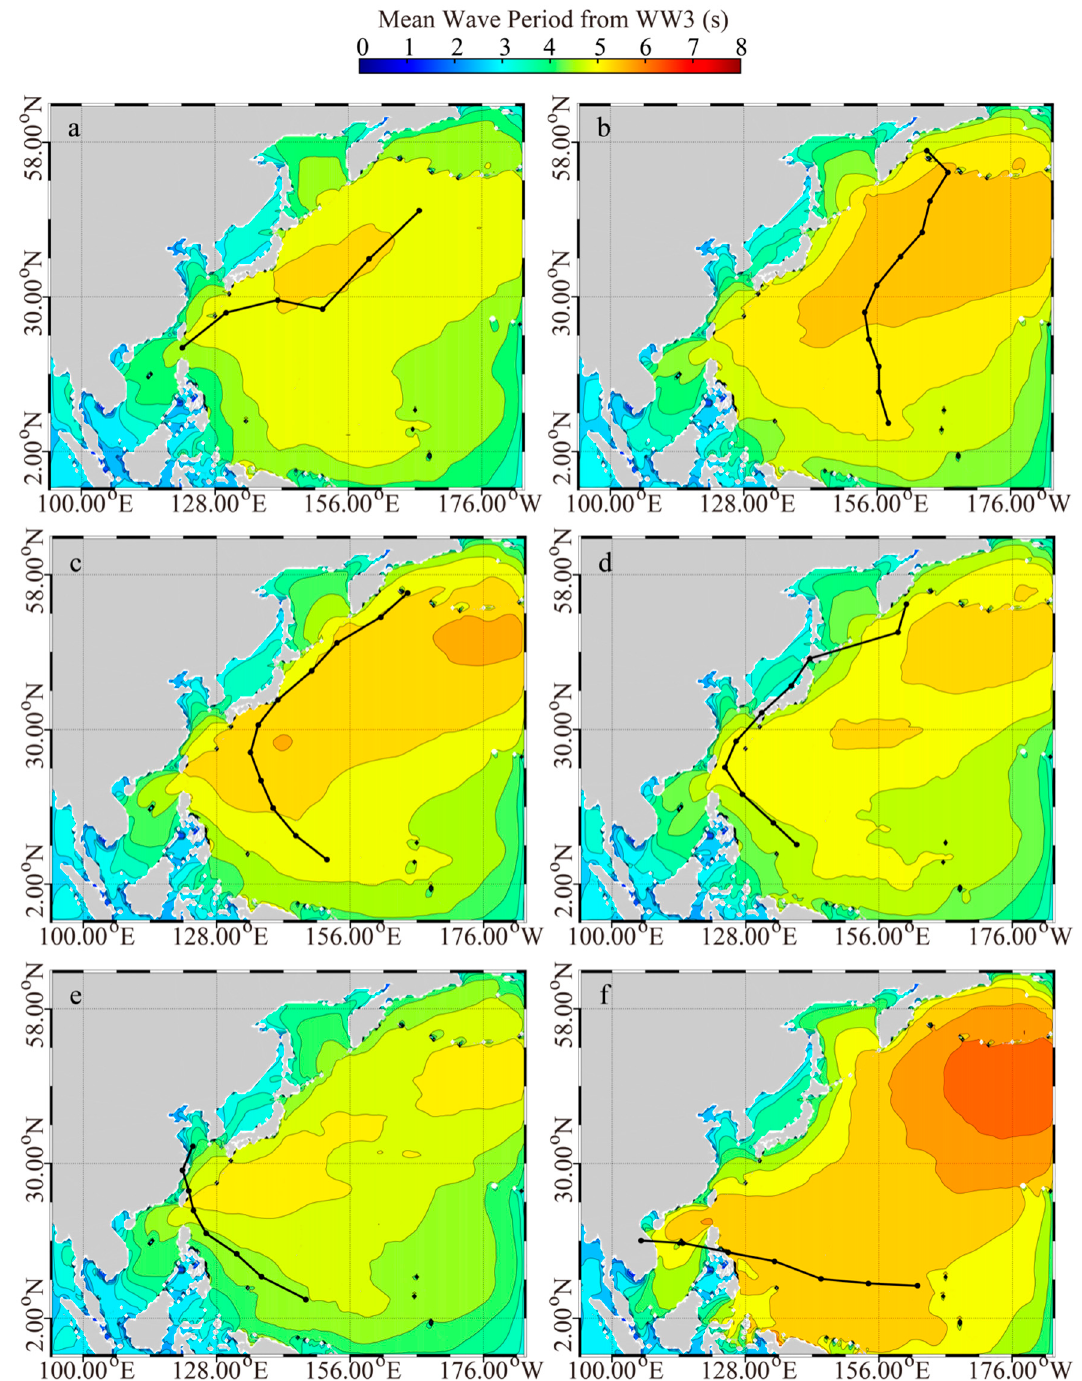
Figure 5. The average result of mean wave period (MWP) from the WW3 for each type of typhoon paths from 1998 to 2018, in which the black polylines represent the typical paths for each type of typhoon paths. ( a ) Northeast shift; ( b ) east turn; ( c ) middle turn; ( d ) west turn; ( e ) northwest shift; and ( f ) west